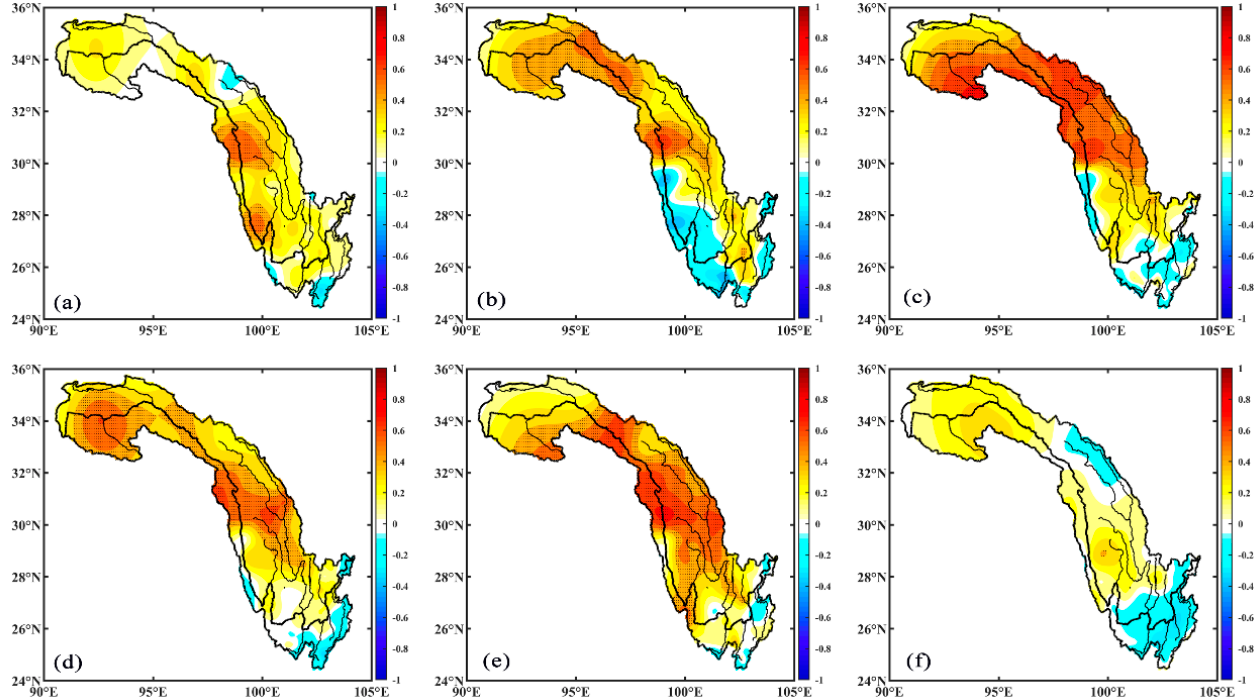
Figure 8. The spatial distribution of correlation coefficients between rainfall and runoff during the main flood season (( a ) PRL and July runoff; ( b ) PRL and August runoff; ( c ) PRL and September runoff; ( d ) PRS and July runoff; ( e ) PRS and August runoff; ( f ) PRS and September runoff. The confidence level of shade is above 0.01).